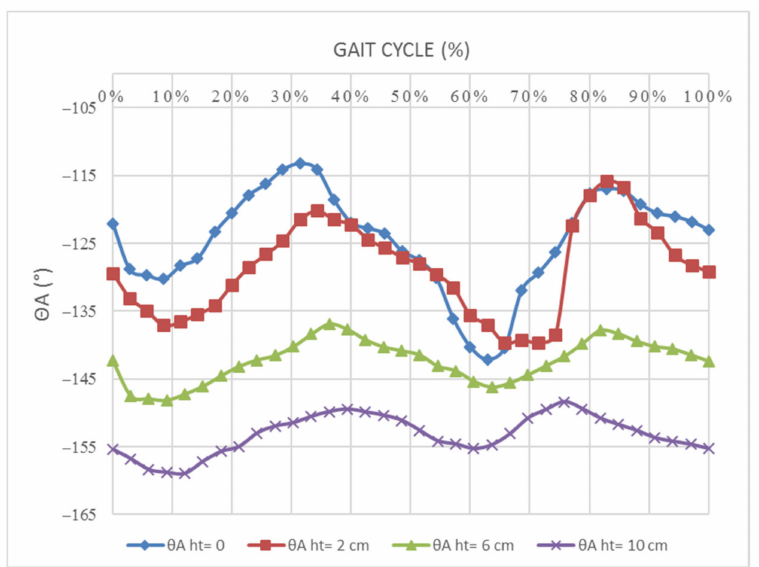
Figure 4. Tibiotalar joint kinematics on the sagittal plane ( ◦ ) during a full gait cycle for heel heights 0, 2, 6 and 10